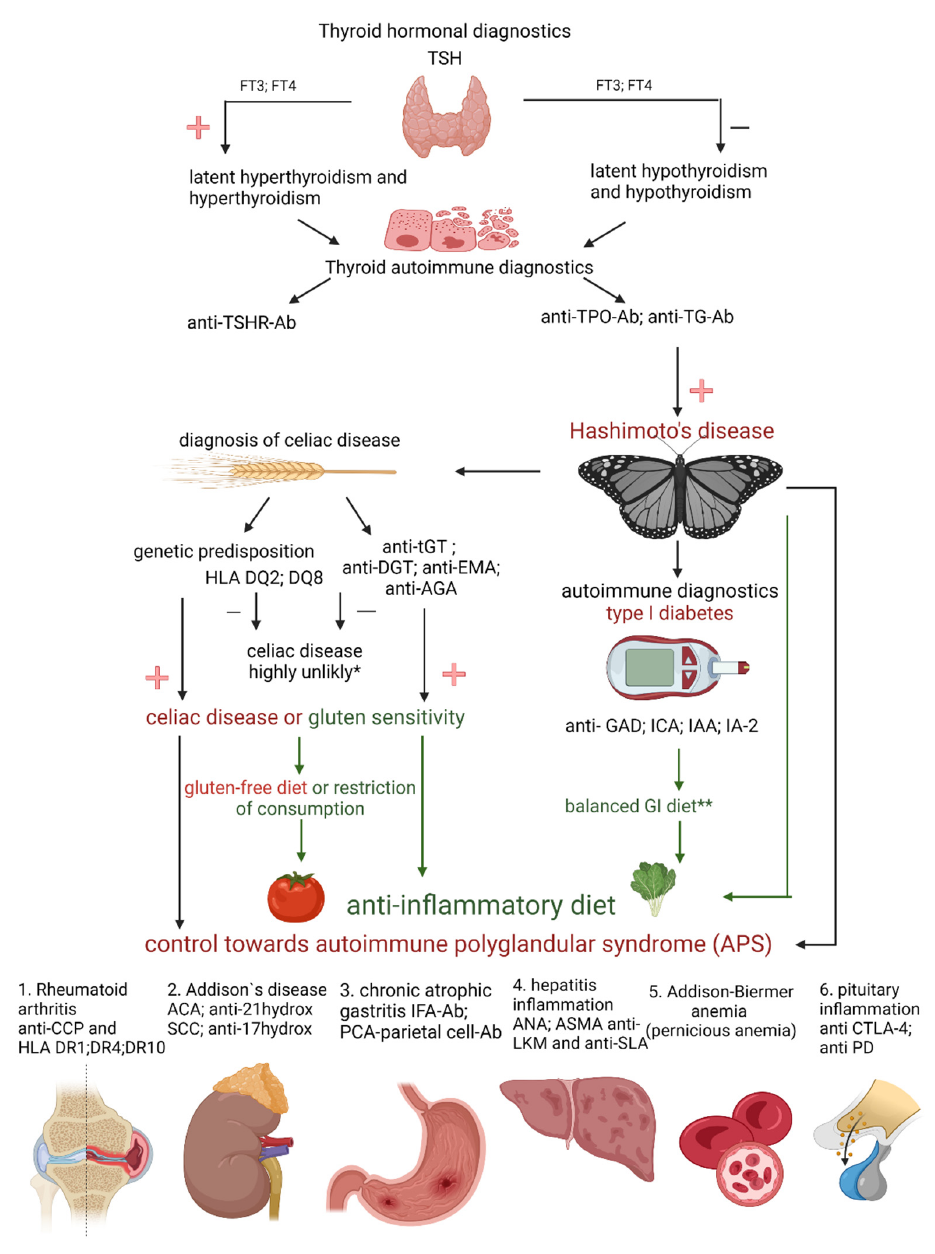
Figure 1. Hashimoto’s warrior alphabet. TSH—thyroid-stimulating hormone; FT3—free